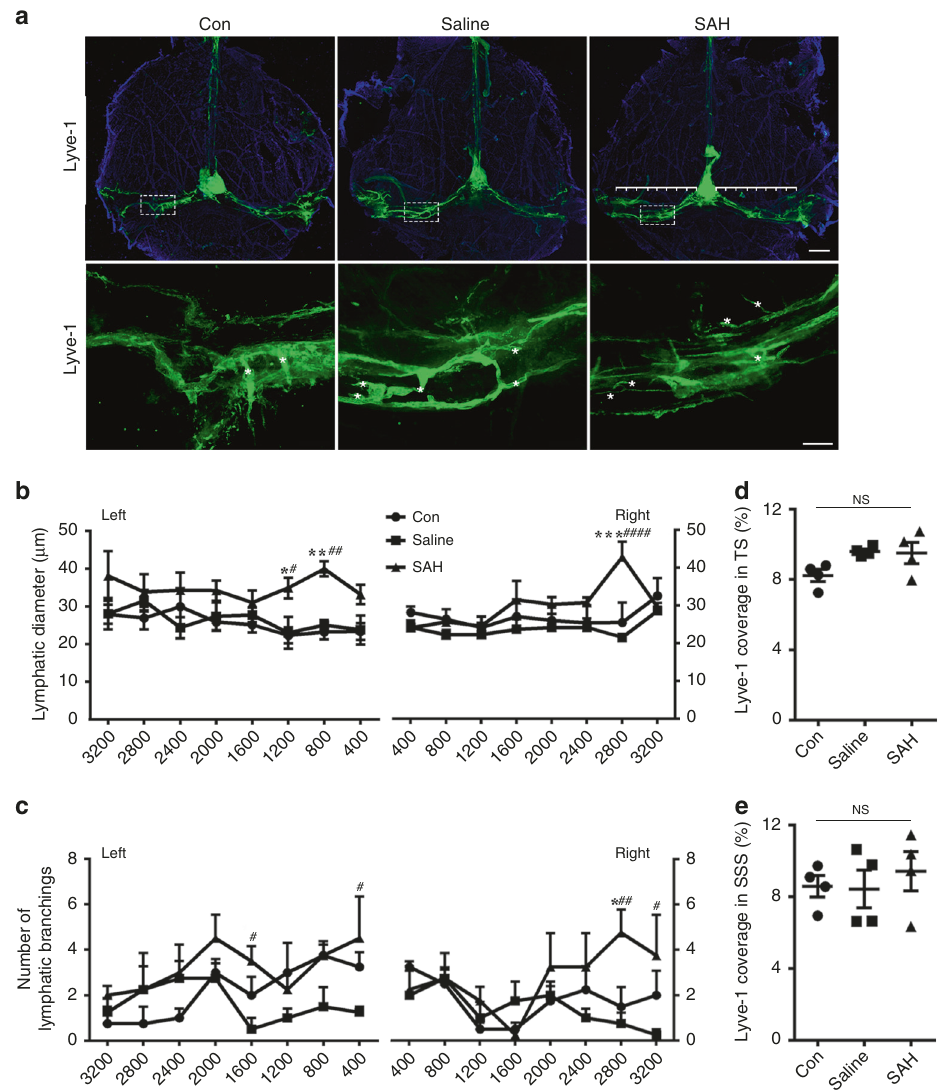
Fig. 7 The diameter, branching, and area of meningeal lymphatics do not change signi fi cantly after 7 days of SAH. a Representative images of meninges whole mounts stained for meningeal lymphatics (Lyve-1, green) from the indicated groups (4 mice per group). The lymphatics on left and right TS were divided into 8 segments (400 μ m each), respectively. Regions of interest of each top image are shown in the row below (white asterisk, the branching of lymphatics). Scale bars, 1 mm (the top images) and 200 μ m (the bottom images). b Quanti fi cation of lymphatic diameters in eight different segments. X axis represents 400 – 3200 μ m distance to the junction of all sinuses. n = 4 mice per group. Left 800, P (Con vs SAH) = 0.002, P (Saline vs SAH) = 0.0067; Left 1200, P (Con vs SAH) = 0.0262, P (Saline vs SAH) = 0.0374; Right 2800, P (Con vs SAH) = 0.0005, P (Saline vs SAH) < 0.0001. c Quanti fi cation of lymphatic branches in eight different segments. X axis represents 400 – 3200 μ m distance to the junction of all sinuses. n = 4 mice per group. Left 1600, P (Saline vs SAH) = 0.0473; Left 400, P (Saline vs SAH) = 0.0287; Right 2800, P (Con vs SAH) = 0.0319, P (Saline vs SAH) = 0.0063; Right 3200, P (Saline vs SAH) = 0.0191. d , e The percentages of Lyve-1 coverage on the TS ( d ) and the SSS ( e ). n = 4 mice per group. All data are presented as mean values ± SD; two-way ANOVA ( b , c ) or one-way ANOVA ( d , e ) with Turkey ’ s multiple-comparison test. * P < 0.05, ** P < 0.01, *** P < 0.001, Con vs SAH, # P < 0.05, ## P < 0.01, #### P < 0.0001, Saline vs SAH. NS, not signi fi cant. Source data are provided as a Source data fi